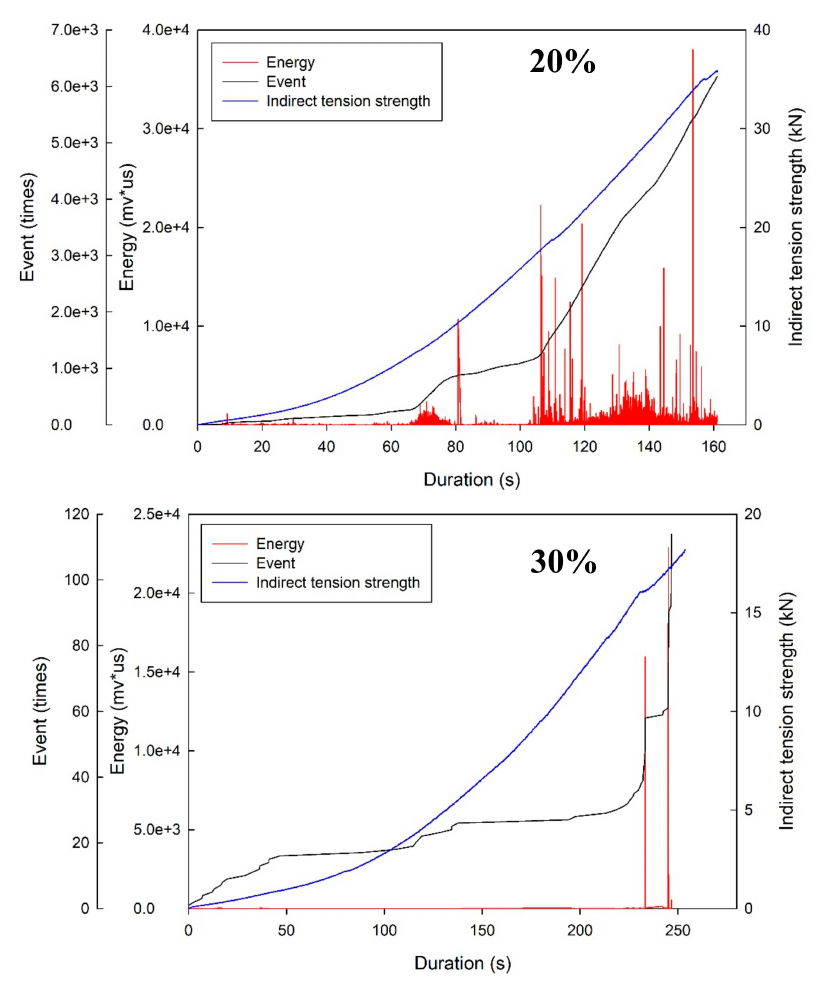
Figure 10. Application of acoustic emission (AE) in the split tensile test to monitor the failure of the specimen. ( a ) Fly-ash replacement 0%; ( b ) Fly-ash replacement 10%; ( c ) Fly-ash replacement 20%; ( d ) Fly-ash replacement 30%.